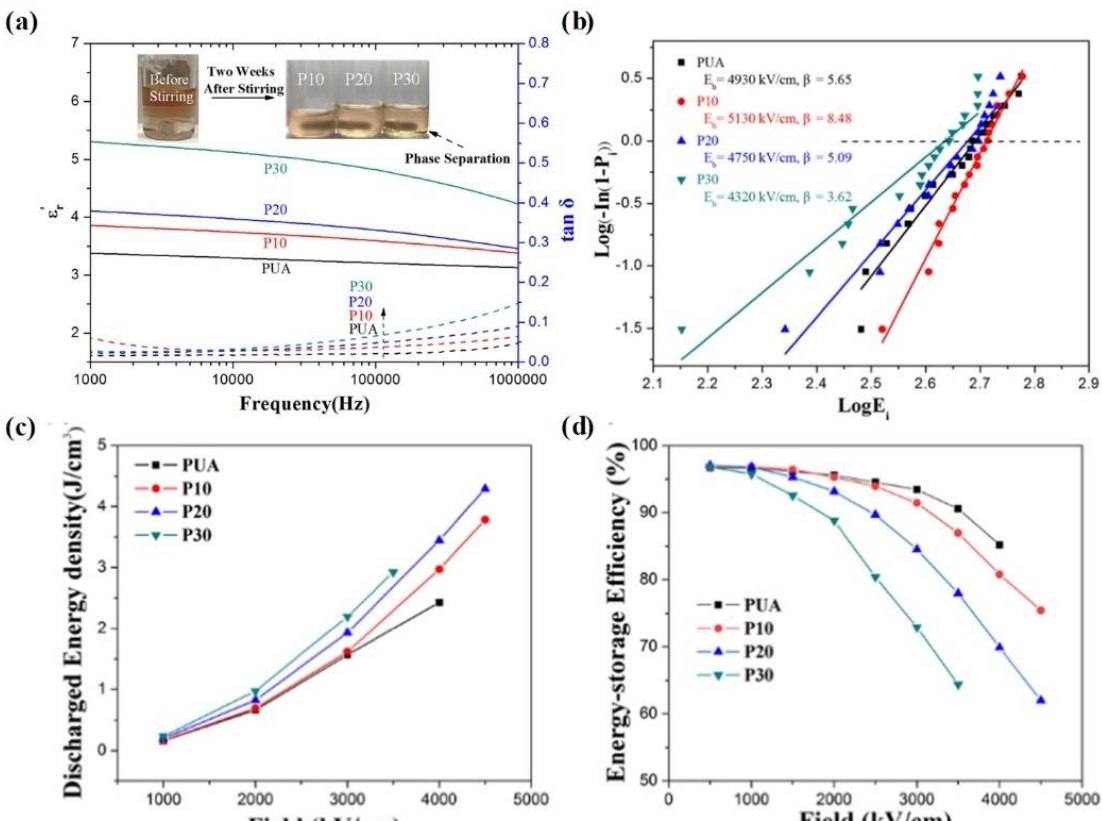
Figure 6. Dielectric constant ( a ), breakdown strength ( b ), discharged energy density ( c ) and energy-storage efficiency of PUA and PUA/P(VDF-TrFE-CFE) blend films ( d ) at ambient temperature. The breakdown strength was tested under a voltage ramp of 0.1 kV s − 1 , and the P-E hysteresis loops were tested at 10 Hz. Reproduced with permission from Ref. [63]. Copyright 2019, IOP.